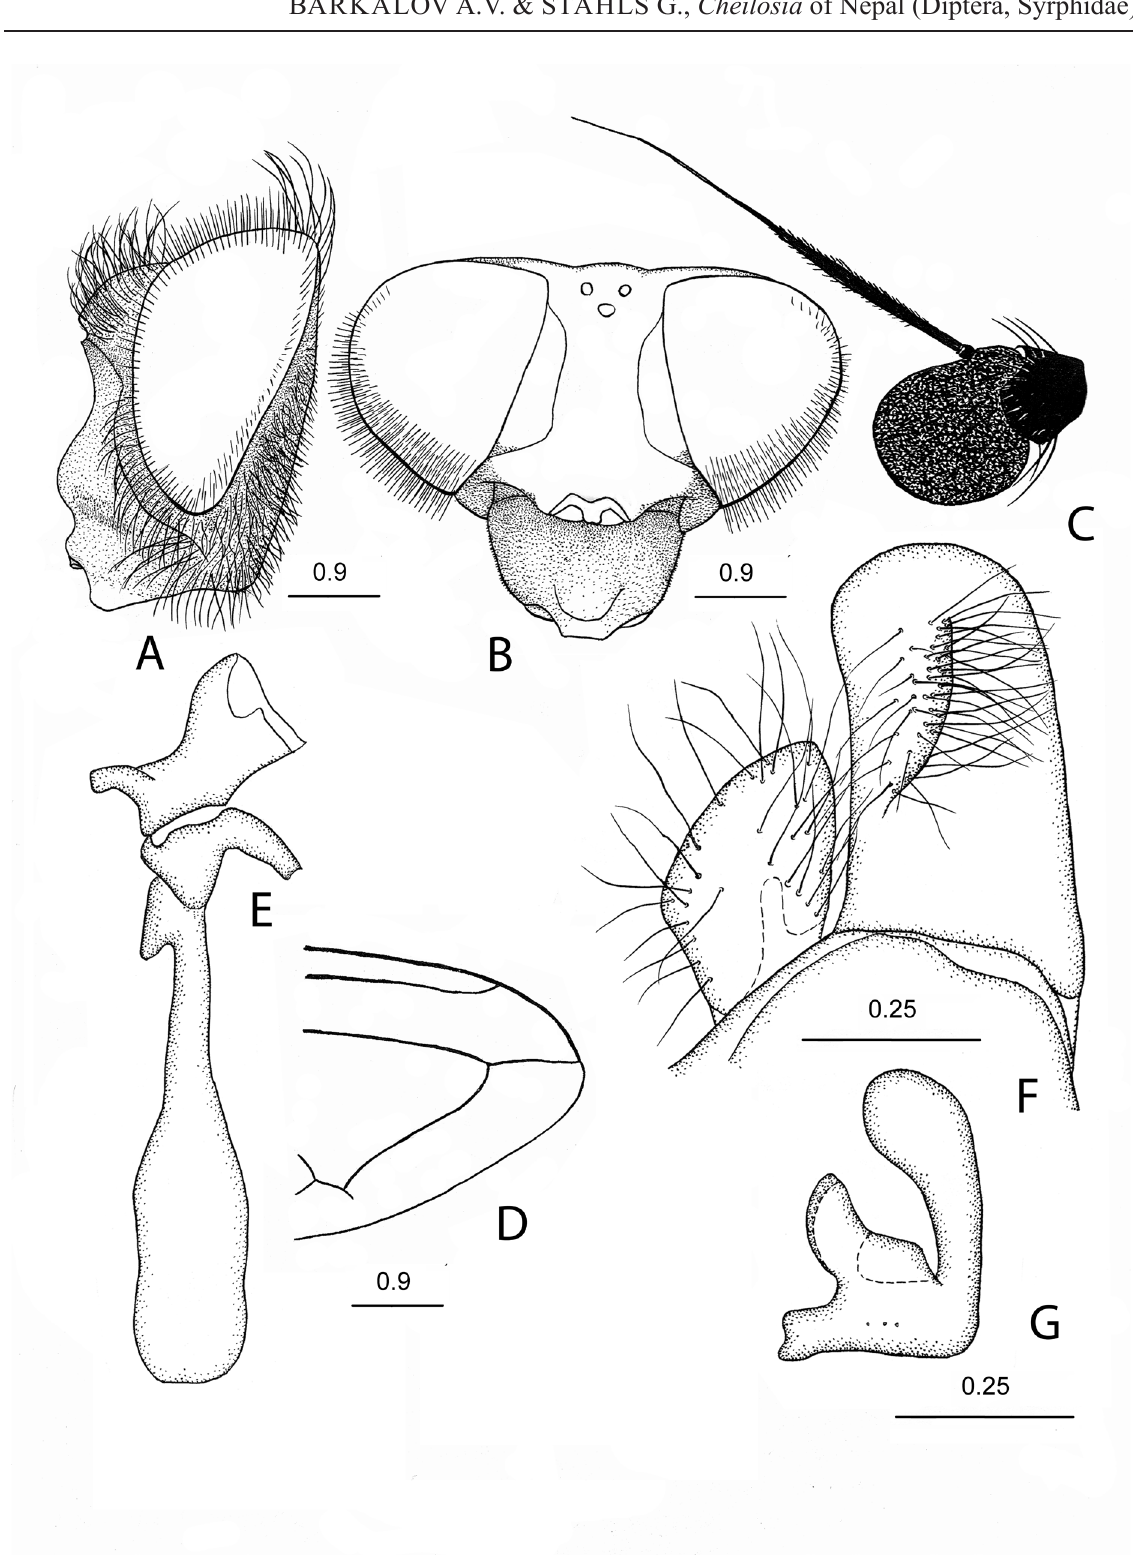
Fig. 29. Cheilosia ( Floccocheila ) illustratoides sp. nov.; A, C–G = holotype, ♂ (NME), B = paratype, ♀ (NME). A . Head, lateral view. B . Head, dorsal view. C . Antenna, lateral view of pedicel and basoflagellomere. D . Tip of wing. E . Aedeagus and aedeagal apodeme, lateral view. F . Surstylus and gonocercus, lateral view. G . Superior lobe of hypandrium, lateral view. Scale bars indicated in